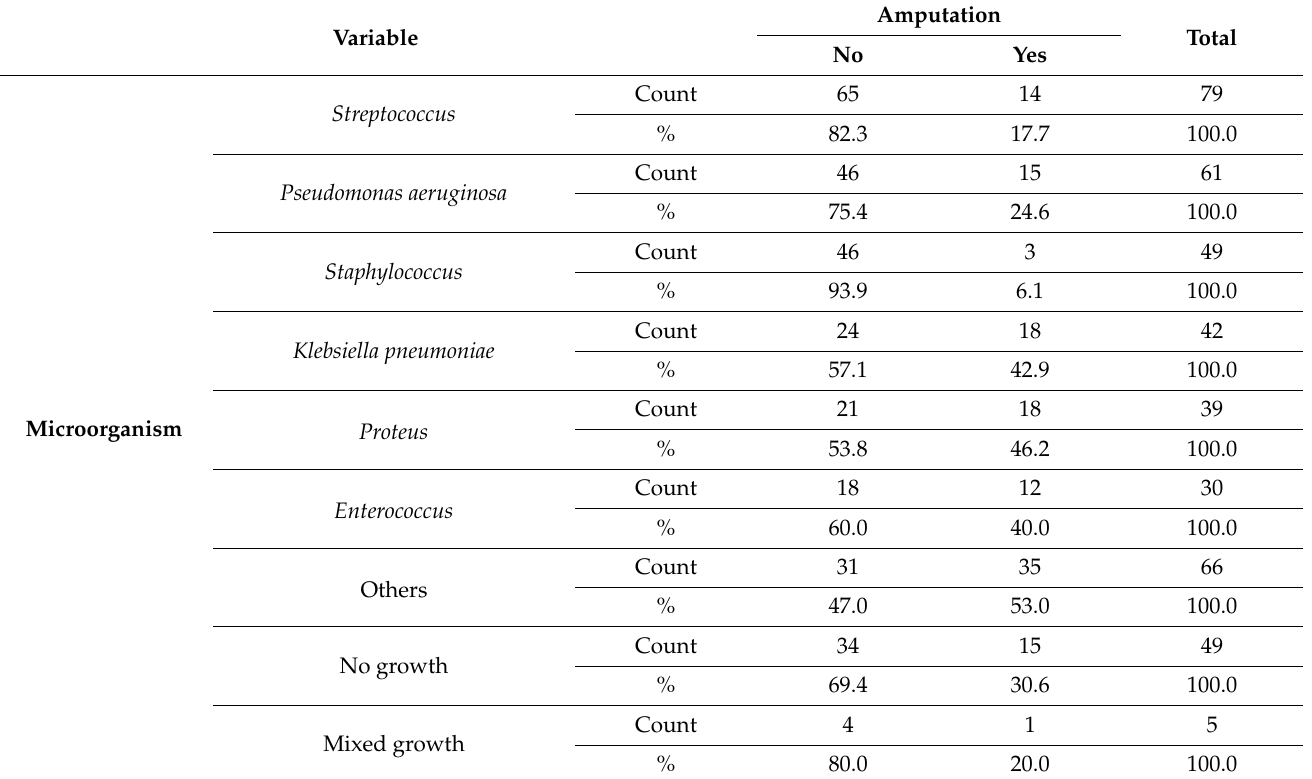
Table 5. Distribution of the microorganism and outcomes.